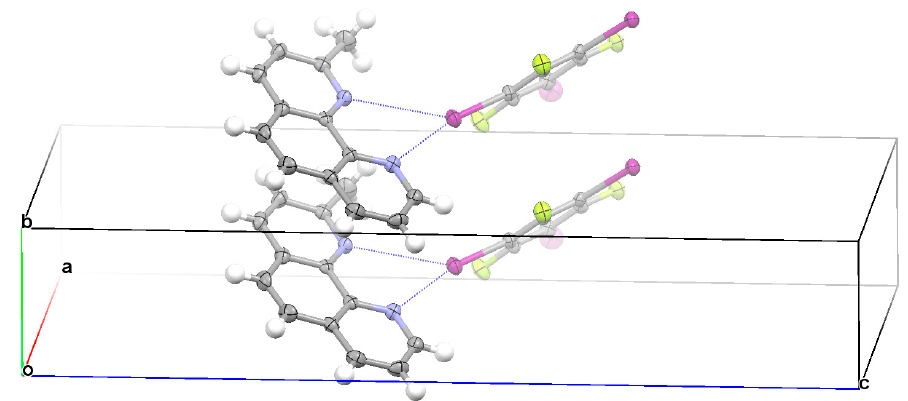
Figure 4. Part of the crystal structure of III showing the formation of an asymmetrical bifurcated halogen bond, π · · · π stacking interaction between two TFTIB molecules, and π · · · π stacking interaction halogen bond, π ··· π stacking interaction between two TFTIB molecules, and π ··· π stacking interaction between two CH3PHEN between two CH3PHEN molecules.